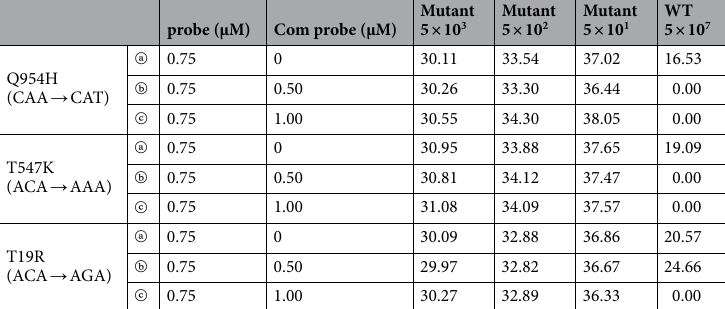
Table 2. Correlation between Com probe and nonspecific signal and Ct value changes.